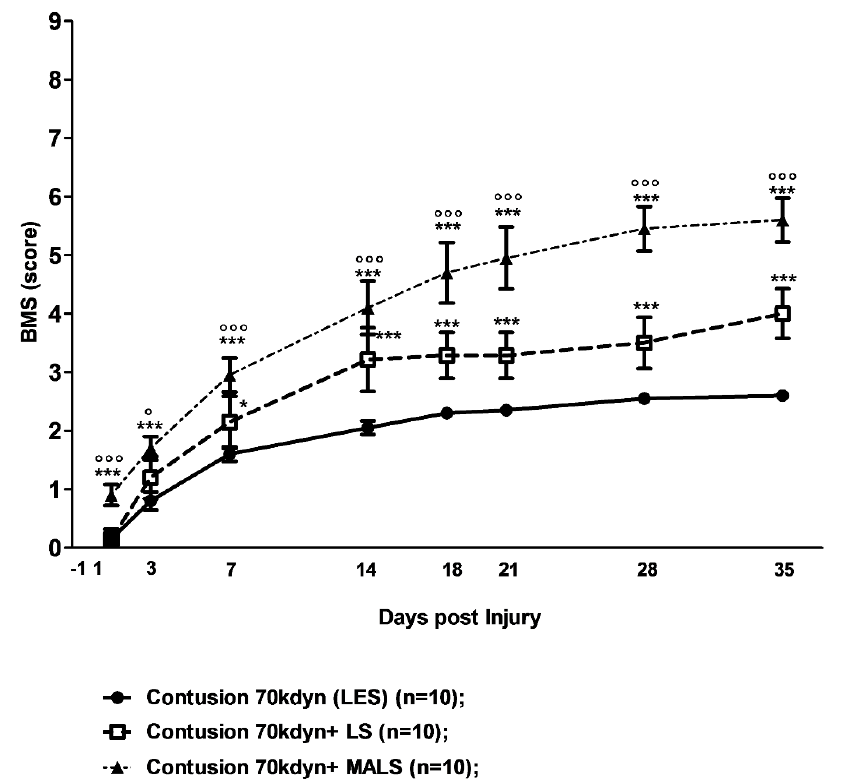
Figure 2. MALS promotes recovery of hind limb function. The evaluation of hind limb motor functional recovery was determined by the open field locomotion test [37]. Lesioned mice showed a remarkable and long-lasting improvement when treated with MALS. The groups were randomized, and the analysis was performed in double-blind fashion. Values represent mean ± SD (n = 10). Statistical di ff erences were evaluated by means of two-way ANOVA test followed by Bonferroni’s post-test. *** p < 0.001; * p < 0.05 versus LES (lesioned untreated mice); ◦◦◦ p < 0.001; ◦ p < 0.05 versus LS (lesioned mice treated with